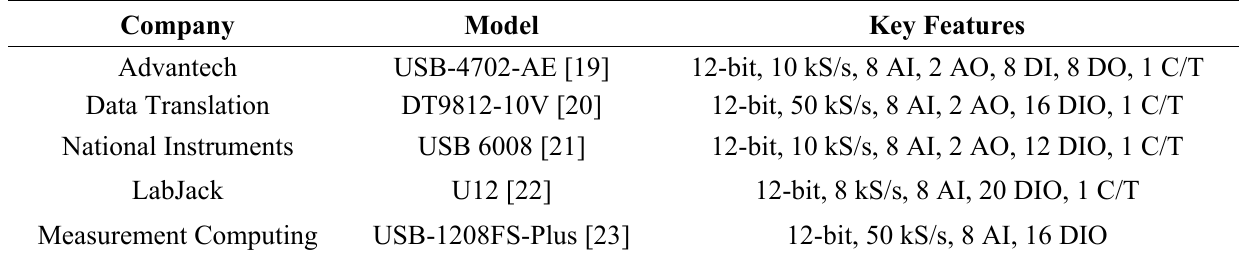
Table 1. Off-the-shelf USB DAQ